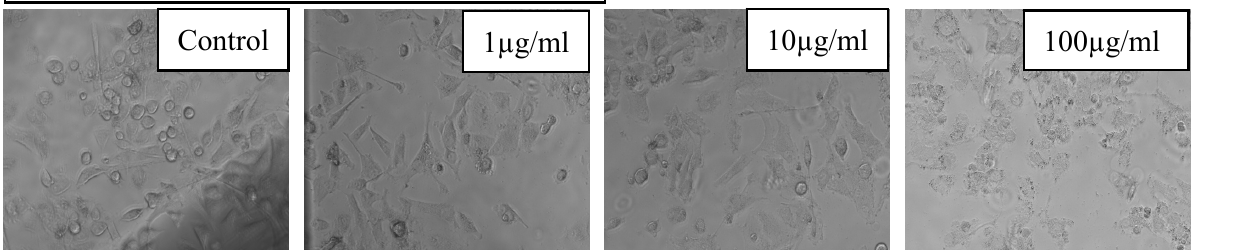
Figure 8. Phagocytic uptake of hydroxyl functionalized MWCNT reinforced PMMA nanocomposites upon exposure to KB cells in the concentration range of 1–100 µg/mL after 0 and 10 min exposure.